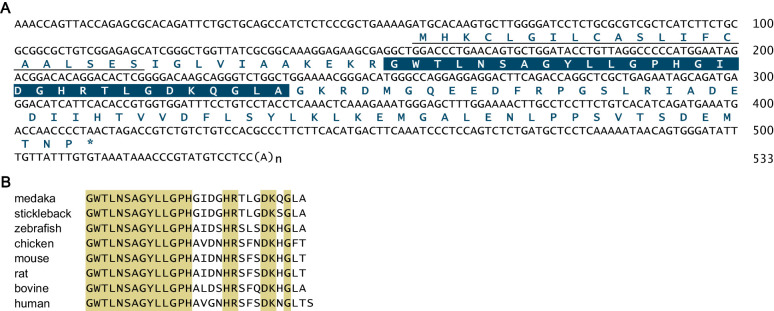
Sequence information for medaka gal.(A) Nucleotide and deduced amino acid sequences of the medaka gal cDNA. The predicted signal peptide is underlined and the mature Gal polypeptide is boxed. Asterisk indicates stop codon. Nucleotide numbers are shown at the right of each sequence line. (B) Comparison of mature GAL polypeptide sequences from medaka and other vertebrate species. Amino acids identical in all sequences are shaded in beige. For species names and GenBank accession numbers, see Supplementary file 2.